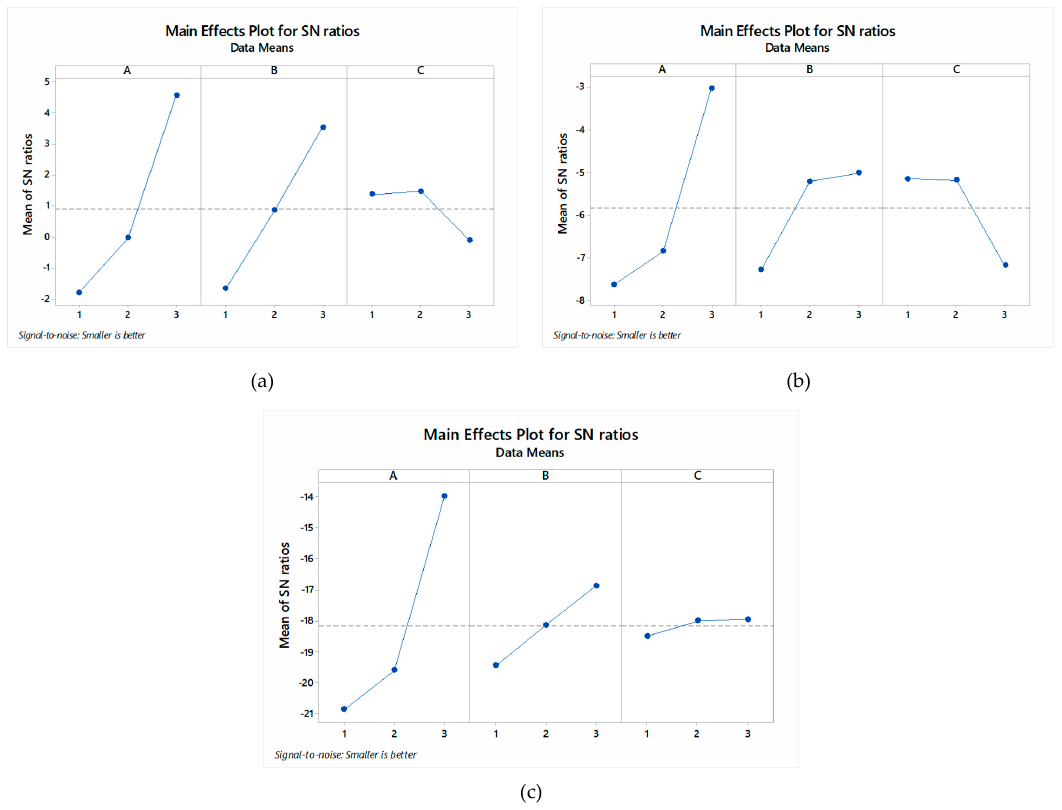
Figure 3. S / N ratio plots for DIW ( a ), DIH ( b ), and R a ( c ). Note: A, B, and C represent feed rate, spindle speed, and depth-of-cut, respectively.